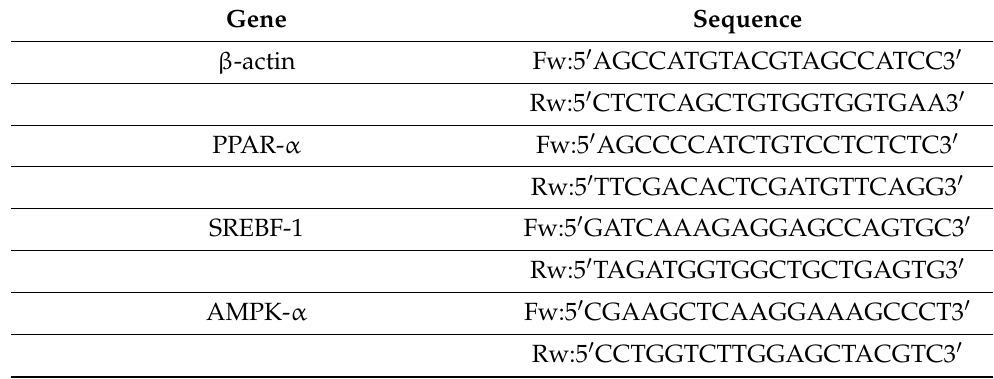
Table 1. Primer list. Gene Sequence β